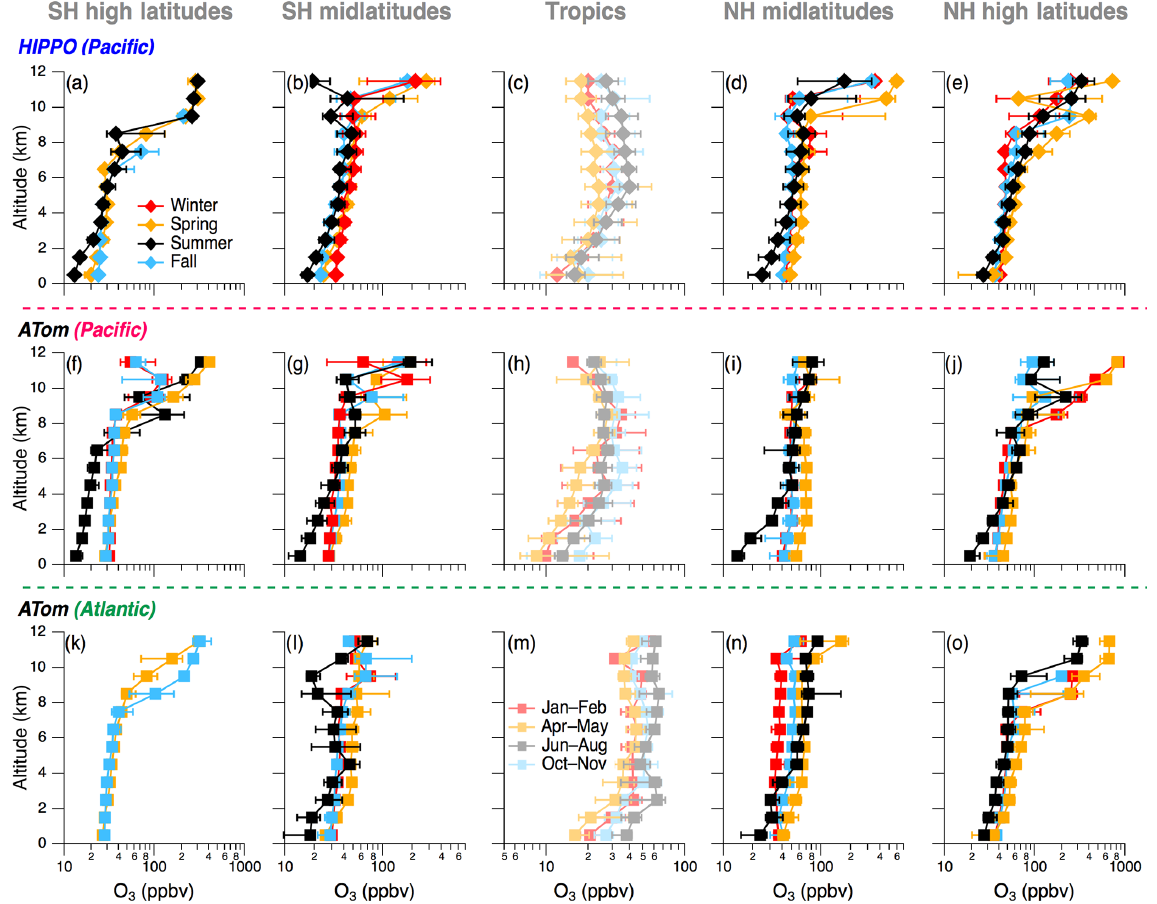
Figure 12. Seasonal variability of the regional O 3 distribution in the Pacific (HIPPO in the top row and ATom in the middle row) and in the Atlantic (ATom in the bottom row). The colors designate the local seasons with red as winter, gold as spring, black as summer, and blue as fall (the corresponding months are indicated for the tropics, using lighter colors). The markers and associated bars correspond to the median, 25th and 75th percentiles, respectively, of the O 3 distribution in every 1km altitude bin. Note the logarithmic scale on the x axes in all panels and the changing scale with latitudinal